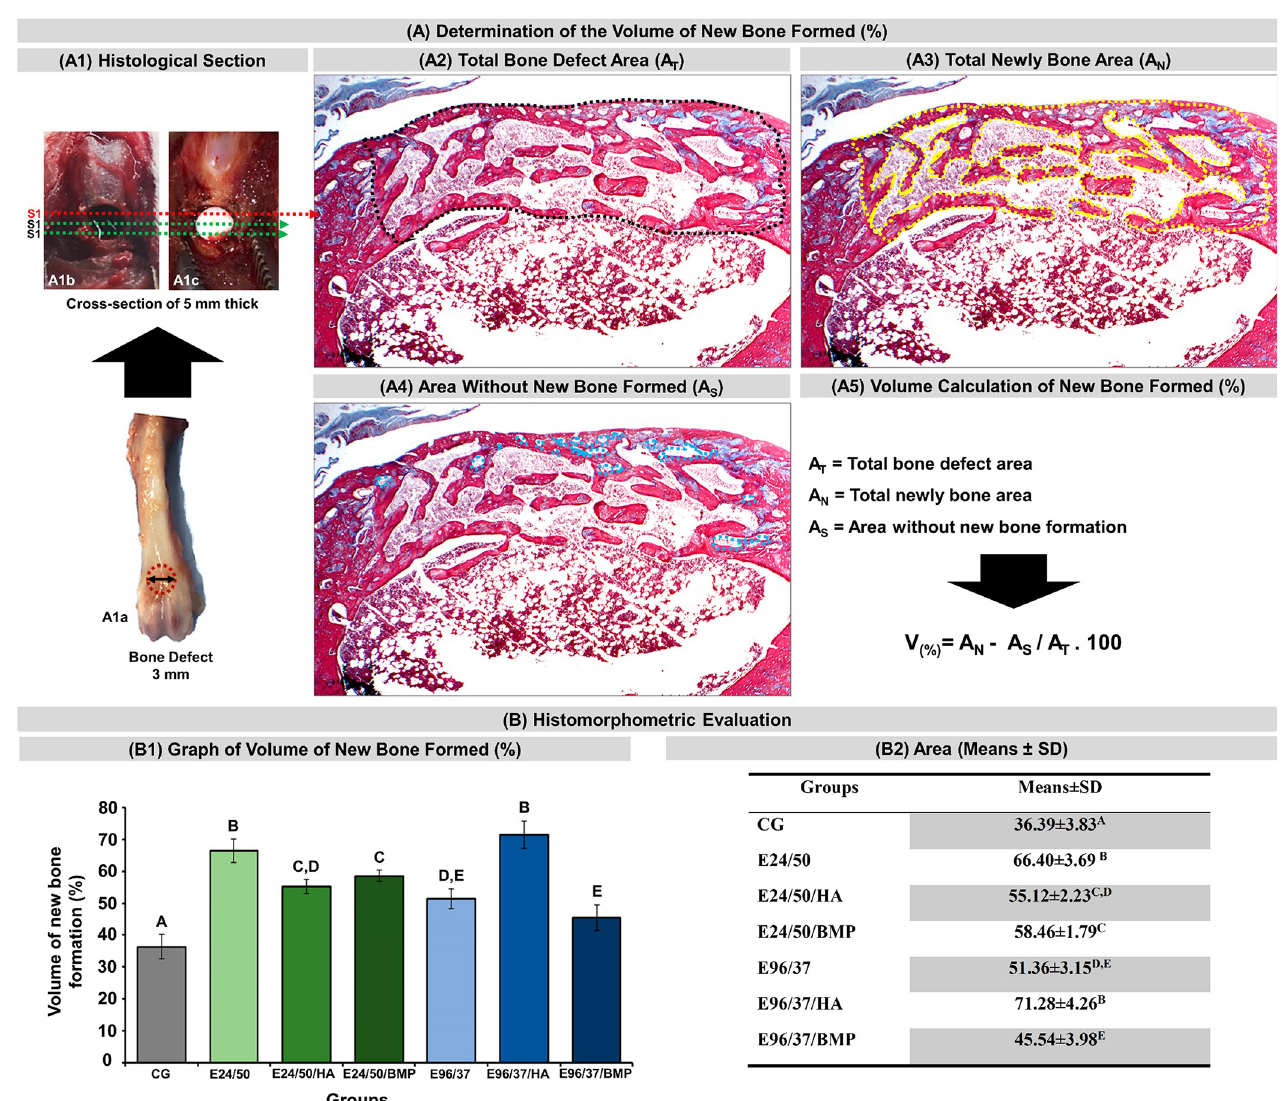
Fig 2. (A) Volume calculation of new bone formed (%) of all experimental groups. (A1) Defect of 3mm in diameter in the anterior metaphyseal region of the distal femur (A1a), defects filled with blood clot (A1b) and elastin matrix (A1c) show the location near the three 5 μ m cross-sectional sections obtained every 1250 μ m apart; black dashed line delimiting the total area of the bone defect (A2); yellow dashed line delimiting the area of newly formed bone (A3); blue dashed line delimiting the areas without new formed bone (A4); volume equation of new formed bone (A5). ( B ) Histomorphometric Evaluations: Graph of the volume of new bone formed (%) in each experimental group at 42 days (B1). Table of percentages of new bone formed from experimental groups (B2). Analysis was performed between the different experimental groups (GC, E24/50, E24/50/HA, E24/50/BMP, E96/37, E96/37/HA, E96 /37/BMP). ANOVA a criterion followed by the Tukey‘s test. Mean ± standard deviation (n = 11 animals/group), where different letters (A 6¼ B 6¼ C 6¼ D 6¼ E) indicate statistically significant differences (p <